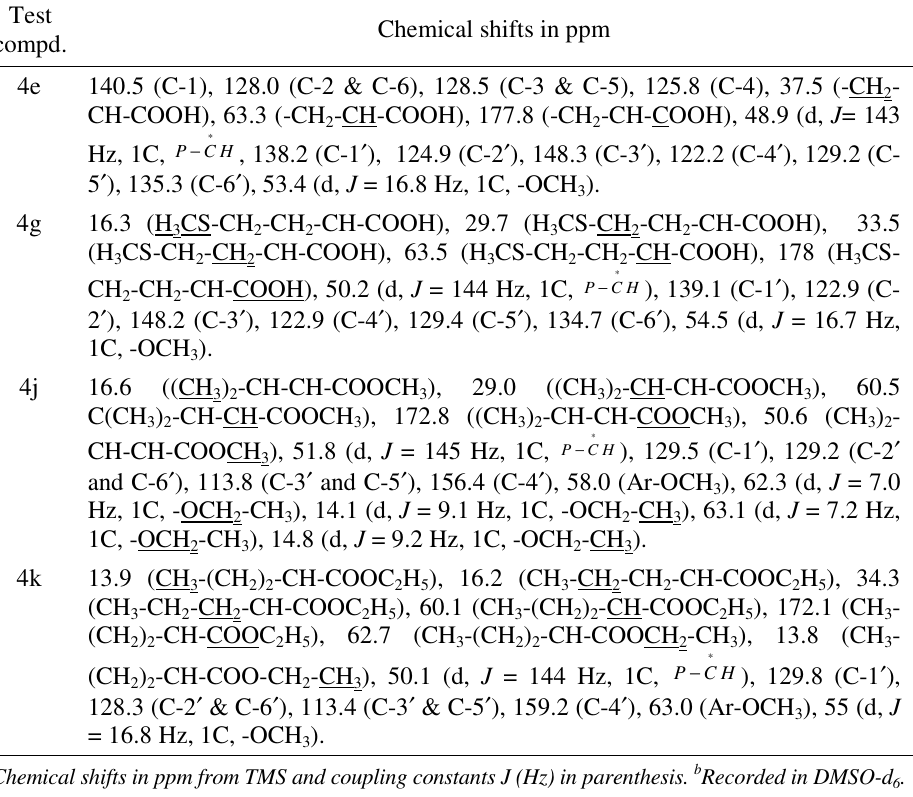
Table 4. FAB mass spectral data of 4e, 4g, 4j, 4l and 4n